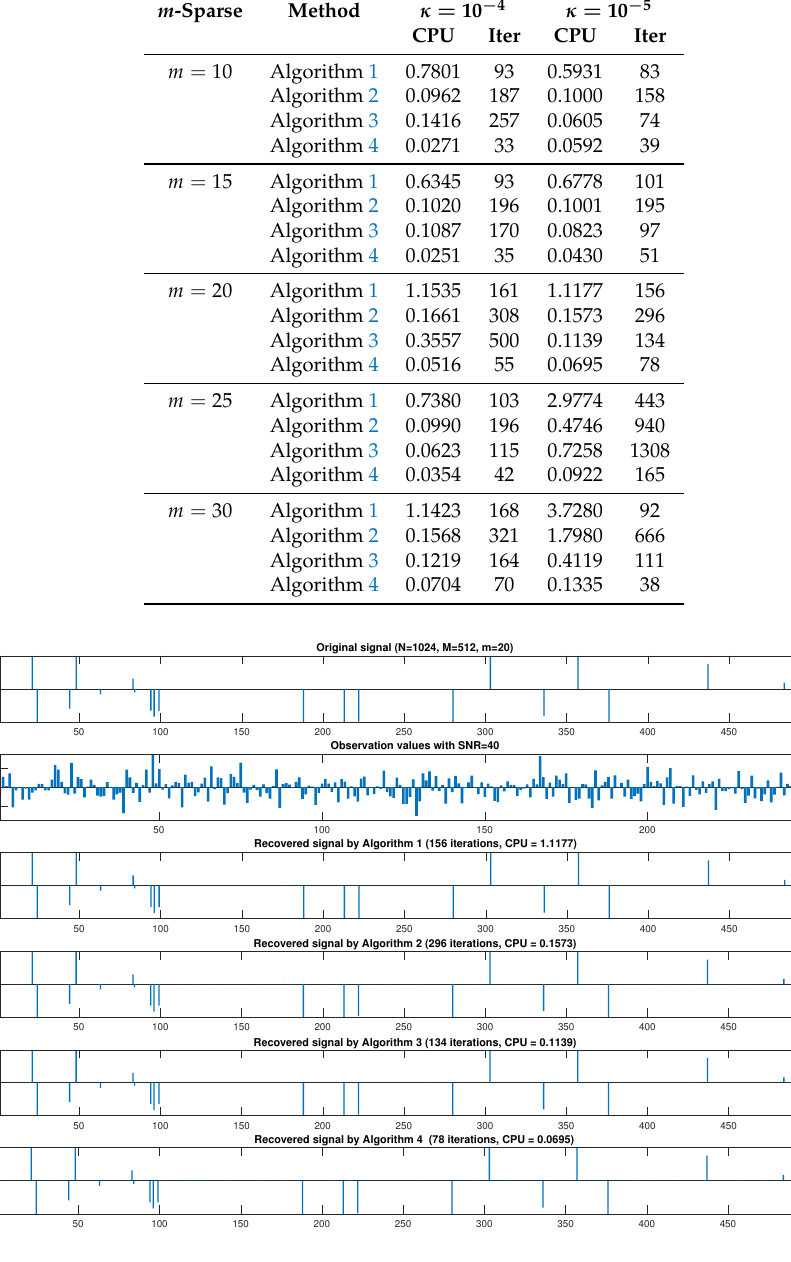
Figure 1. From top to bottom: original signal, observation data and recovered signal by Algorithms 1–4,